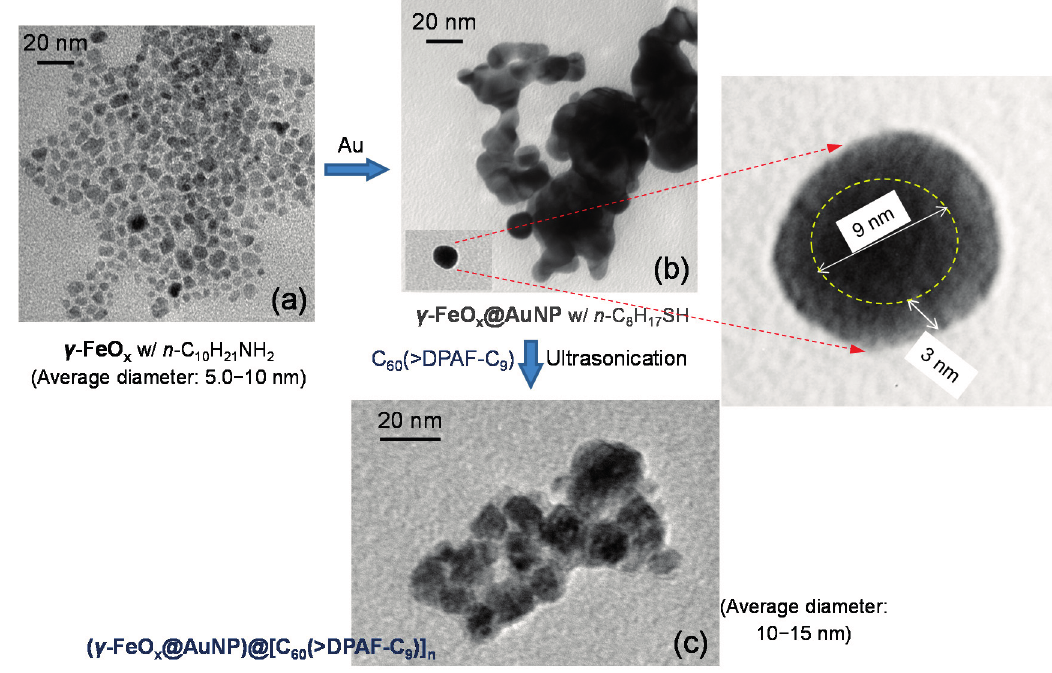
Figure 3. TEM micrographs of ( a ) γ -FeO x (prepared by the method A1); ( b ) γ -FeO x @AuNP, and ( c ) C 60 (>DPAF-C 9 )-encapsulated γ -FeO x @AuNP nanoparticles 3 – 1 showing evolution of particle morphology